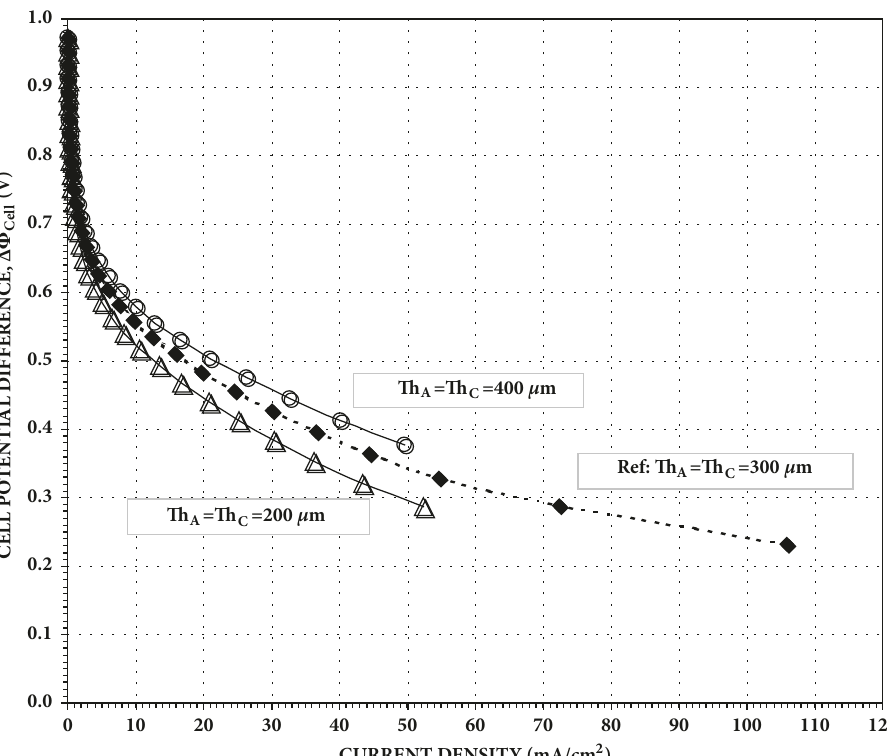
= Th ( 𝜇 m), on the polarization curve for a direct propane fuel A C = Th ( 𝜇 m) for the above three cases were represented by the following symbols: (i) A C